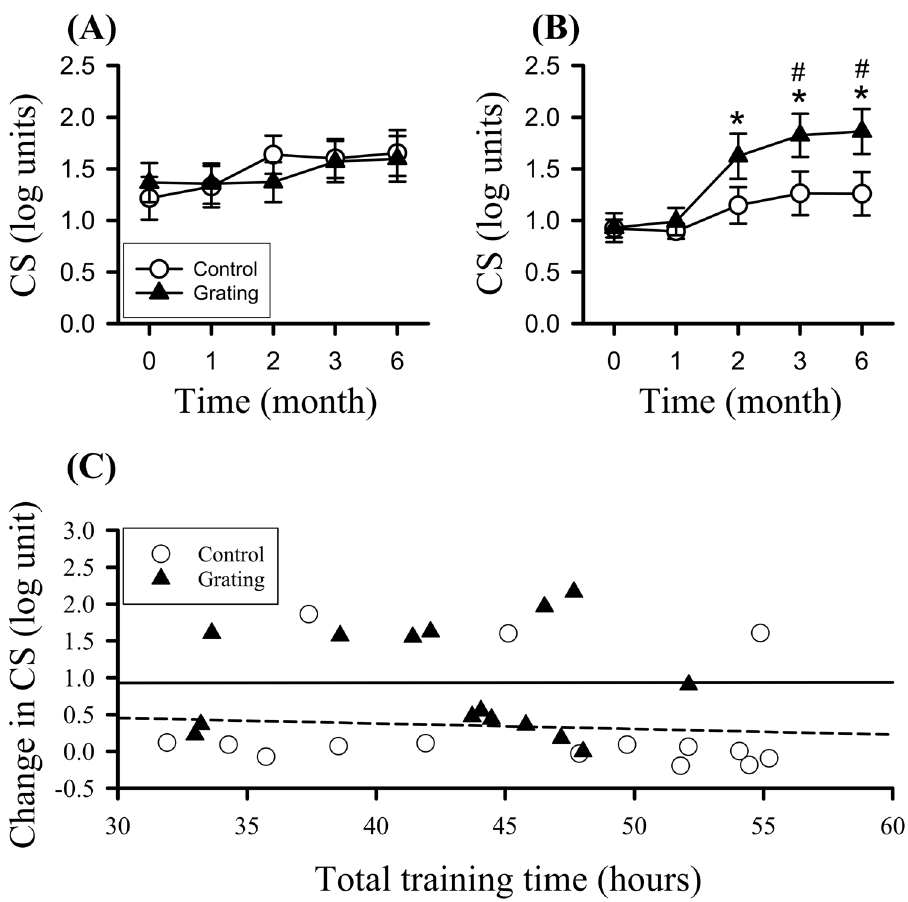
Figure 4. Contrast sensitivity (CS) of 16 cycles per degree (cpd) the baseline (0), 1st, 2nd, 3rd, and 6th months after the training. ( A ) CSs in patched eyes of the control and Grating groups. ( B ) CSs in trained eyes of the control and Grating groups. *p < 0.05 versus baseline, # p < 0.05 versus the control group. ( C ) Relationship between 16-cpd CS gain from the 6th month to baseline and total training time in trained eye of the two groups. The long dashed (control) and solid (Grating) lines represent the linear regression line fit the